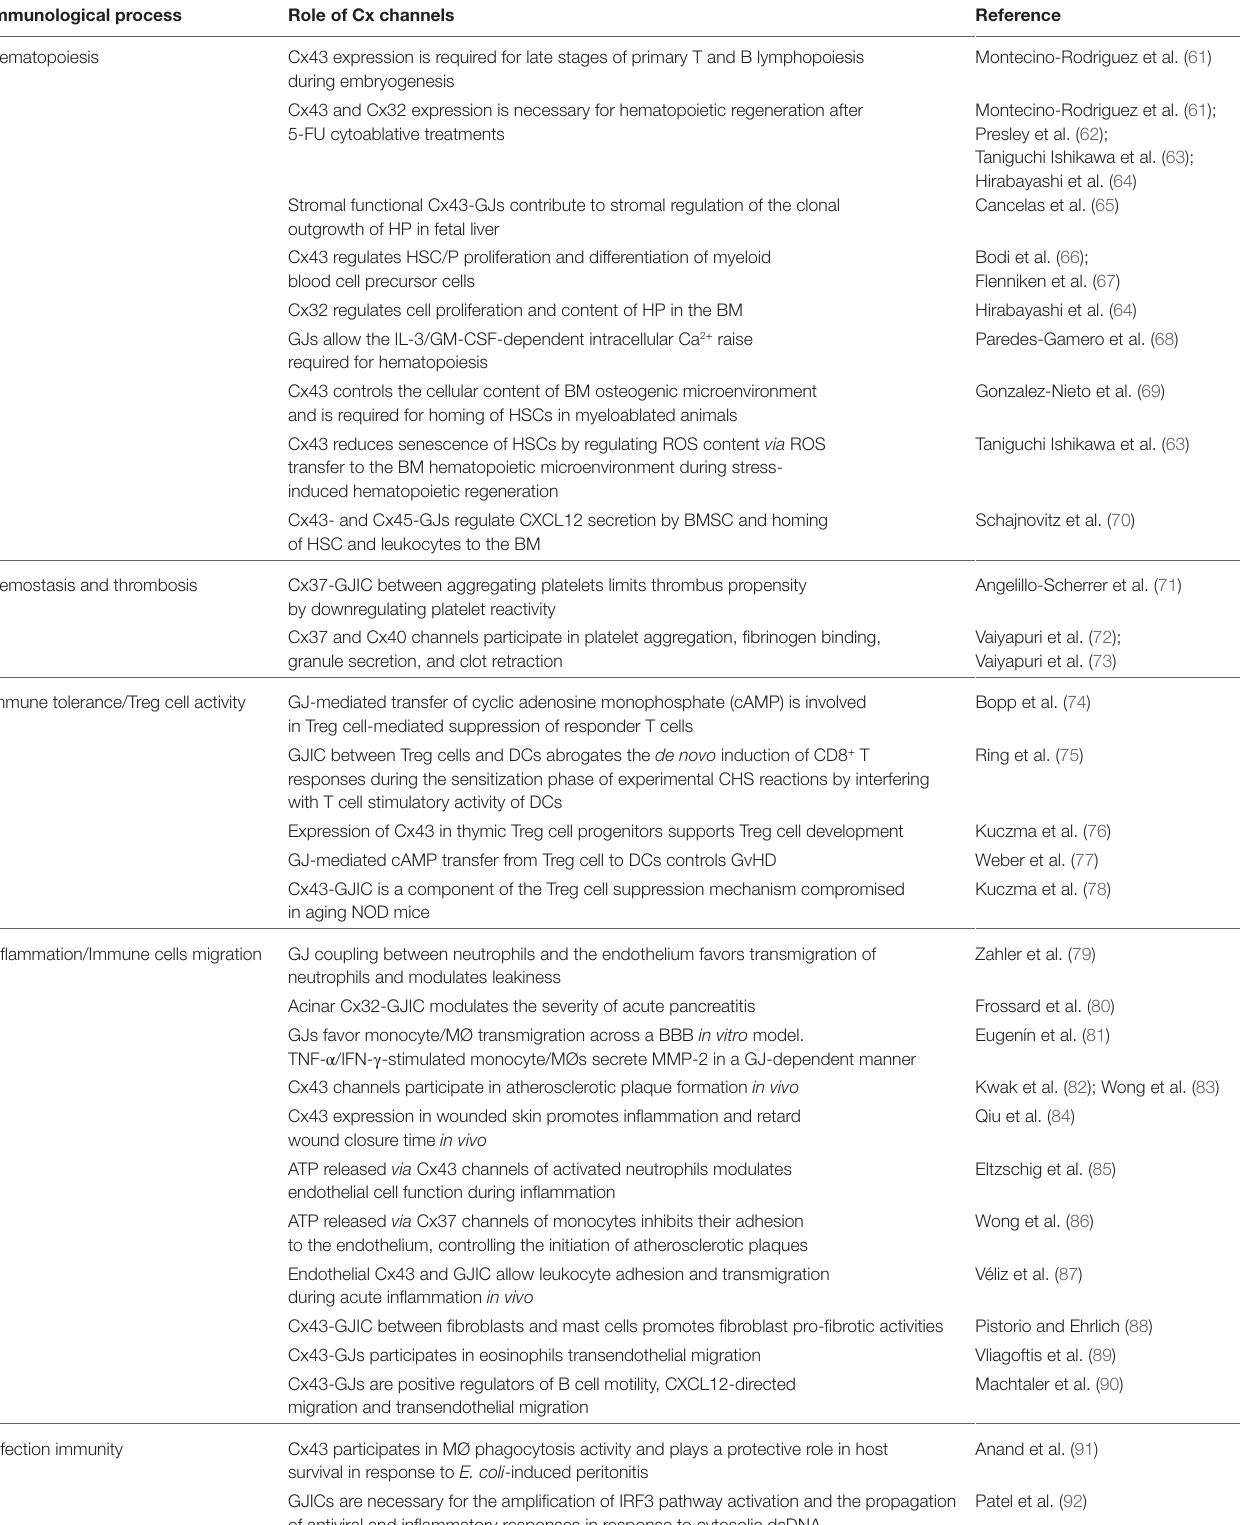
Table 2 | Summary of the role of connexin (Cx) channels in